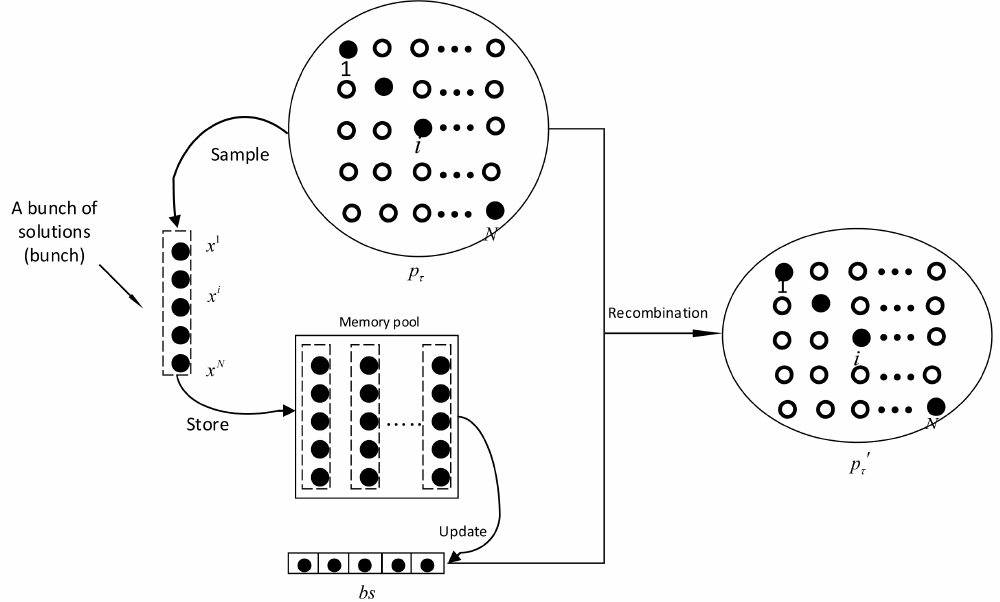
Figure 2. The working principle of the subproblem-based bunchy memory (SBM)